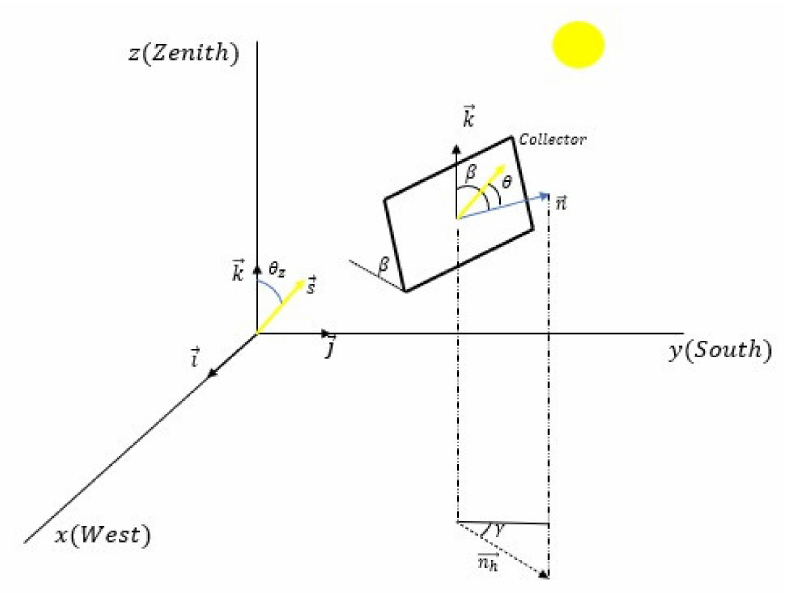
Figure 2. Vector magnitudes characteristic of the geometry of the collectors of a self-consumption PV